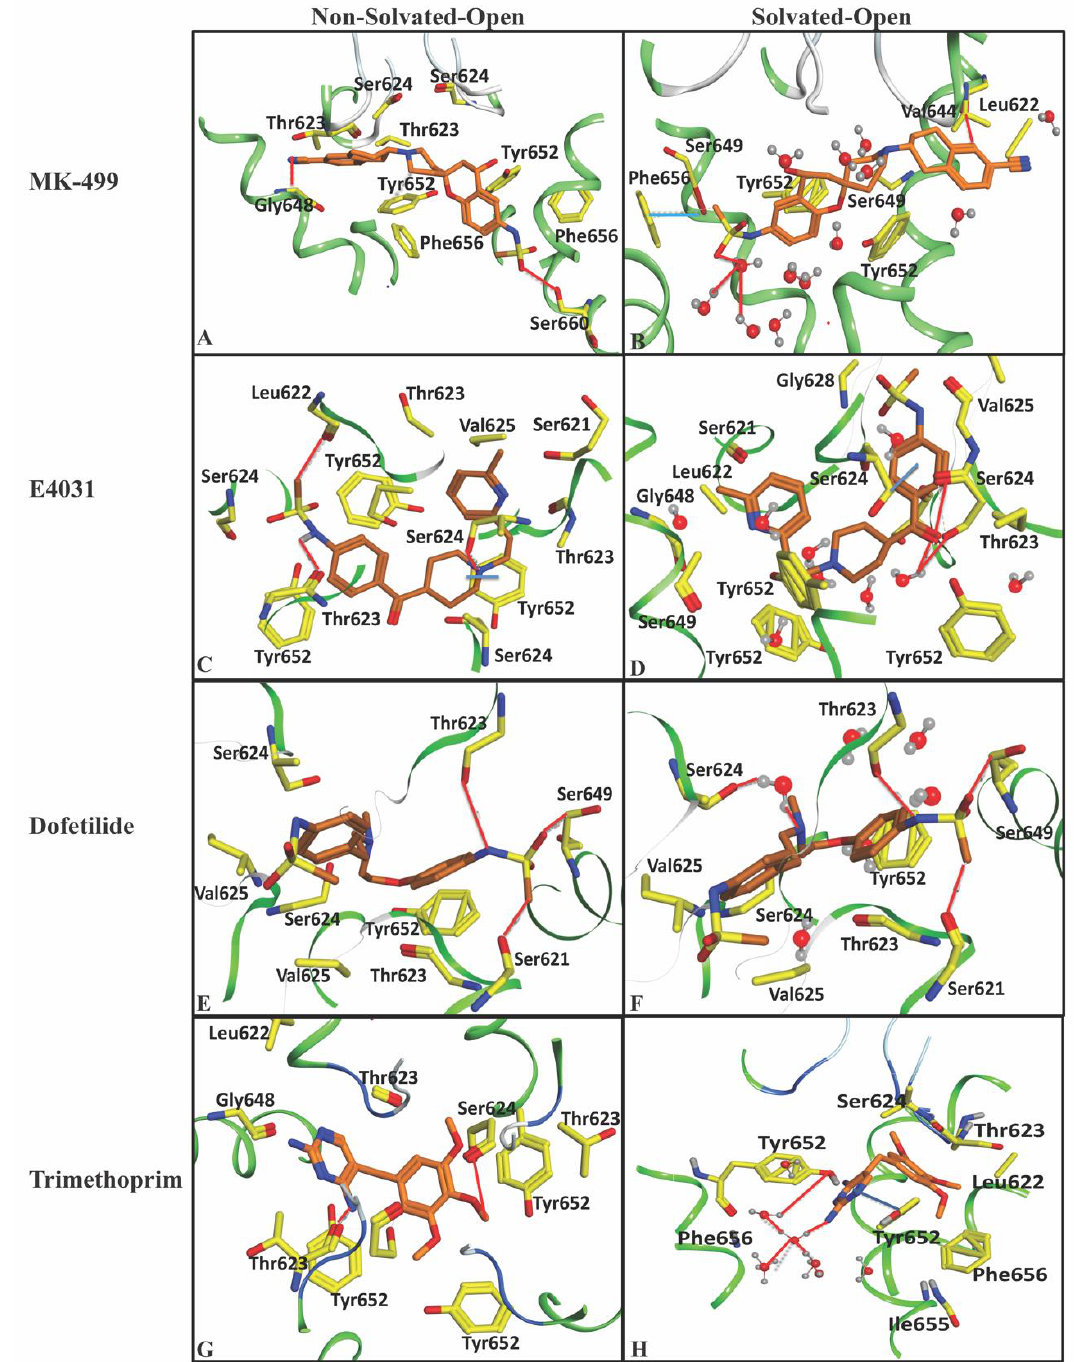
Figure 5. Showing docked ligands in non-solvated open and solvated open binding cavity of hERG cryo_EM structure. ( A ) Final docked pose of Mk-499 in non-solvated-open binding cavity showing hydrogen bond interaction with Gly648, Ser624 and Ser660 and π – π interaction with Tyr652. ( B ) MK-499 showing hydrogen bonding with Leu622 and ligand–water interaction. ( C ) E4031 shows hydrogen bond with Leu622 and Thr623 in non-solvated hERG cavity. ( D ) Docked E4031 final pose showing hydrogen bond and water mediated interactions with hydrophobic interaction with Ser624. ( E ) Dofetilide docked in non-solvated-open binding cavity of hERG showing hydrogen bonding with Ser621 and Thr623. ( F ) Final pose of dofetilide showing water mediated interactions with Ser624 and hydrogen bonding with Ser621 and Thr623. ( G ) Final pose of docked trimethoprim in non-solvated open cavity showing hydrogen bonding with Thr623 and Ser624. ( H ) Trimethoprim final pose docked in solvated open binding cavity showed water mediated hydrogen bond interaction with Tyr652 and π – π interaction with